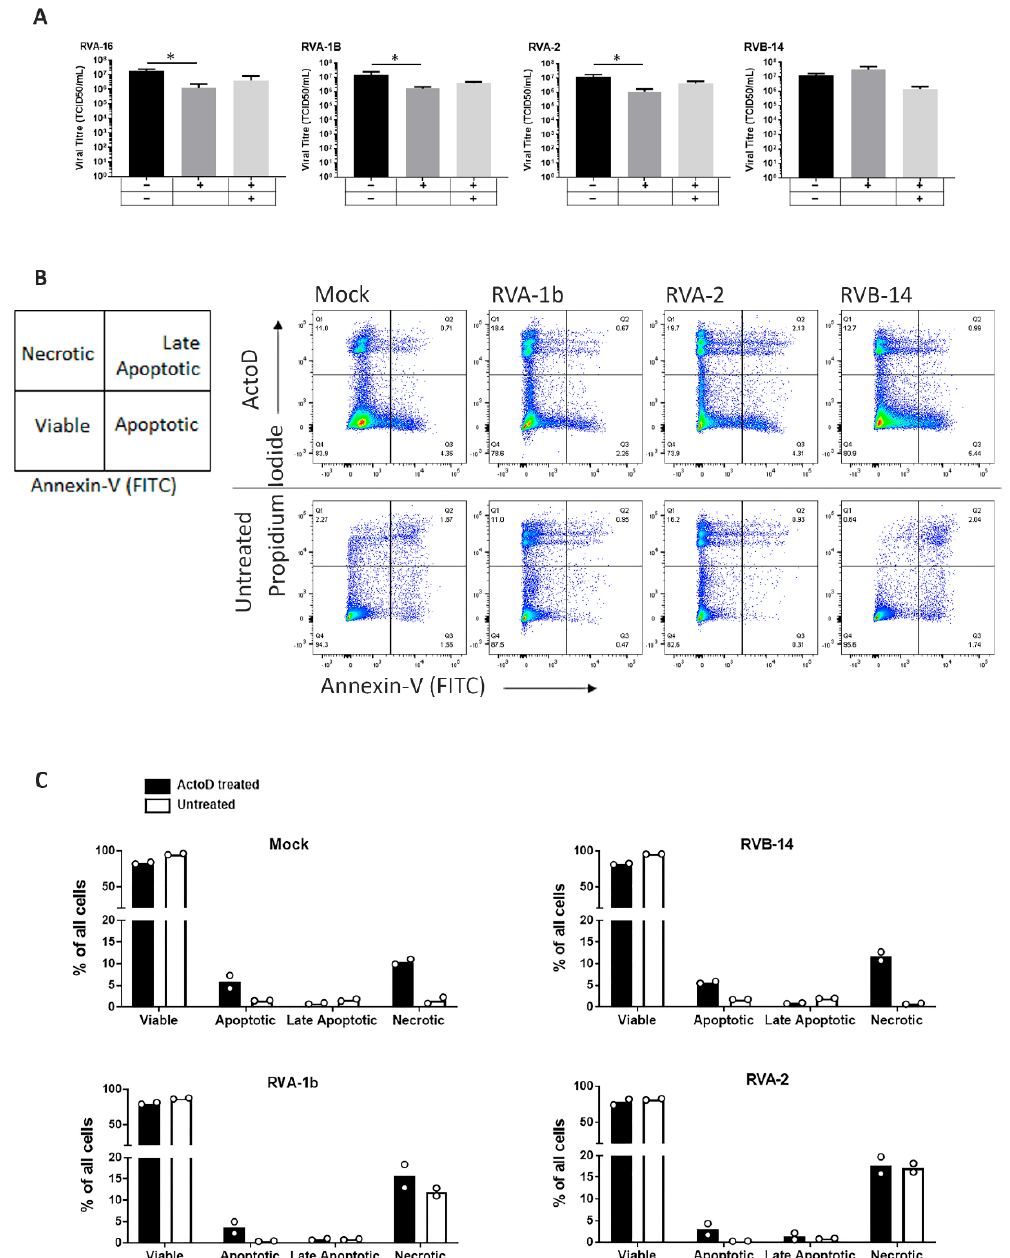
Figure 4. RVA but not RVB strains modulate apoptotic pathways. O-HeLa cells were infected with the RV strain indicated at an M.O.I. of 3, for 1 h of adsorption. ( A ) Cells were treated at 3 hpi with ActoD (5 µg/mL) or remained untreated followed by caspase 8 inhibitor (4 µM) at 4 hpi, or remained untreated. At 24 hpi, virus cultures were frozen and thawed. The virus was clarified and titrated. Results are expressed as the mean of 3 independent experiments and error bars are the SEM. * p < 0.05. ( B ) At 3 hpi, cells were treated with ActoD (5 µg/mL) or remained untreated. Both adherent and non-adherent cells were collected at 12 hpi and stained with Annexin-V (FITC) antibodies and Propidium Iodide and processed for FACS analysis. Live cells were subject to doublet discrimination before quadratic gating to determine viable (AnV − Pi − ), apoptotic (AnV + Pi − ), late apoptotic (AnV + Pi+), or necrotic (AnV − Pi+) populations. Representative FACS plots are shown. ( C ) Quantitation as % of single cells (all cells) of data represented in ( B ). Data are representative of two experiments performed in triplicate and columns represent the mean with the two data points shown on each.